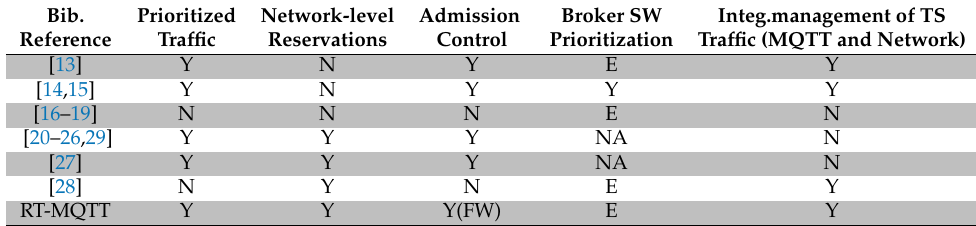
Table 1. State-of-the-art characteristics summary. Bib. Prioritized Network-level Admission Integ.management of TS